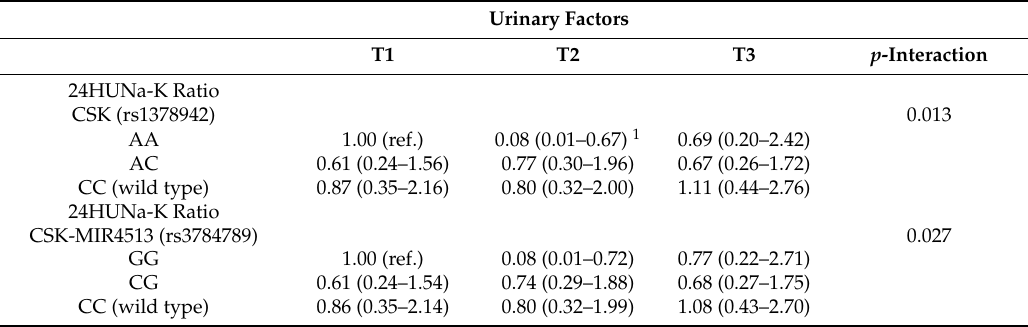
Table 5. Significant interactions between gene polymorphisms and 24 h estimated urinary factors obtained with Tanaka formula in sample